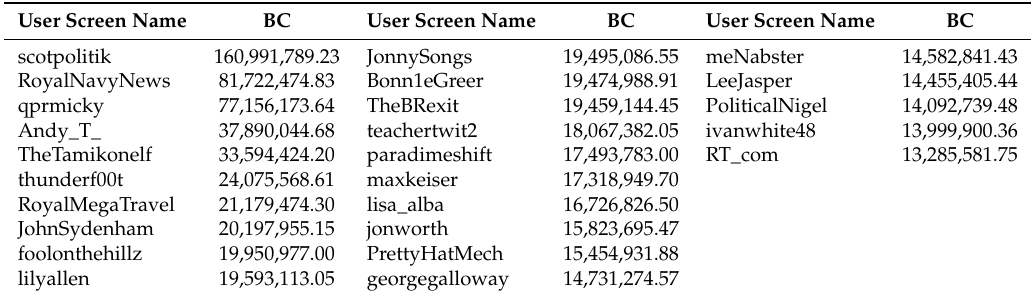
Table 5. Summary of the key hubs identified in the data set as measured by betweenness centrality. User Screen